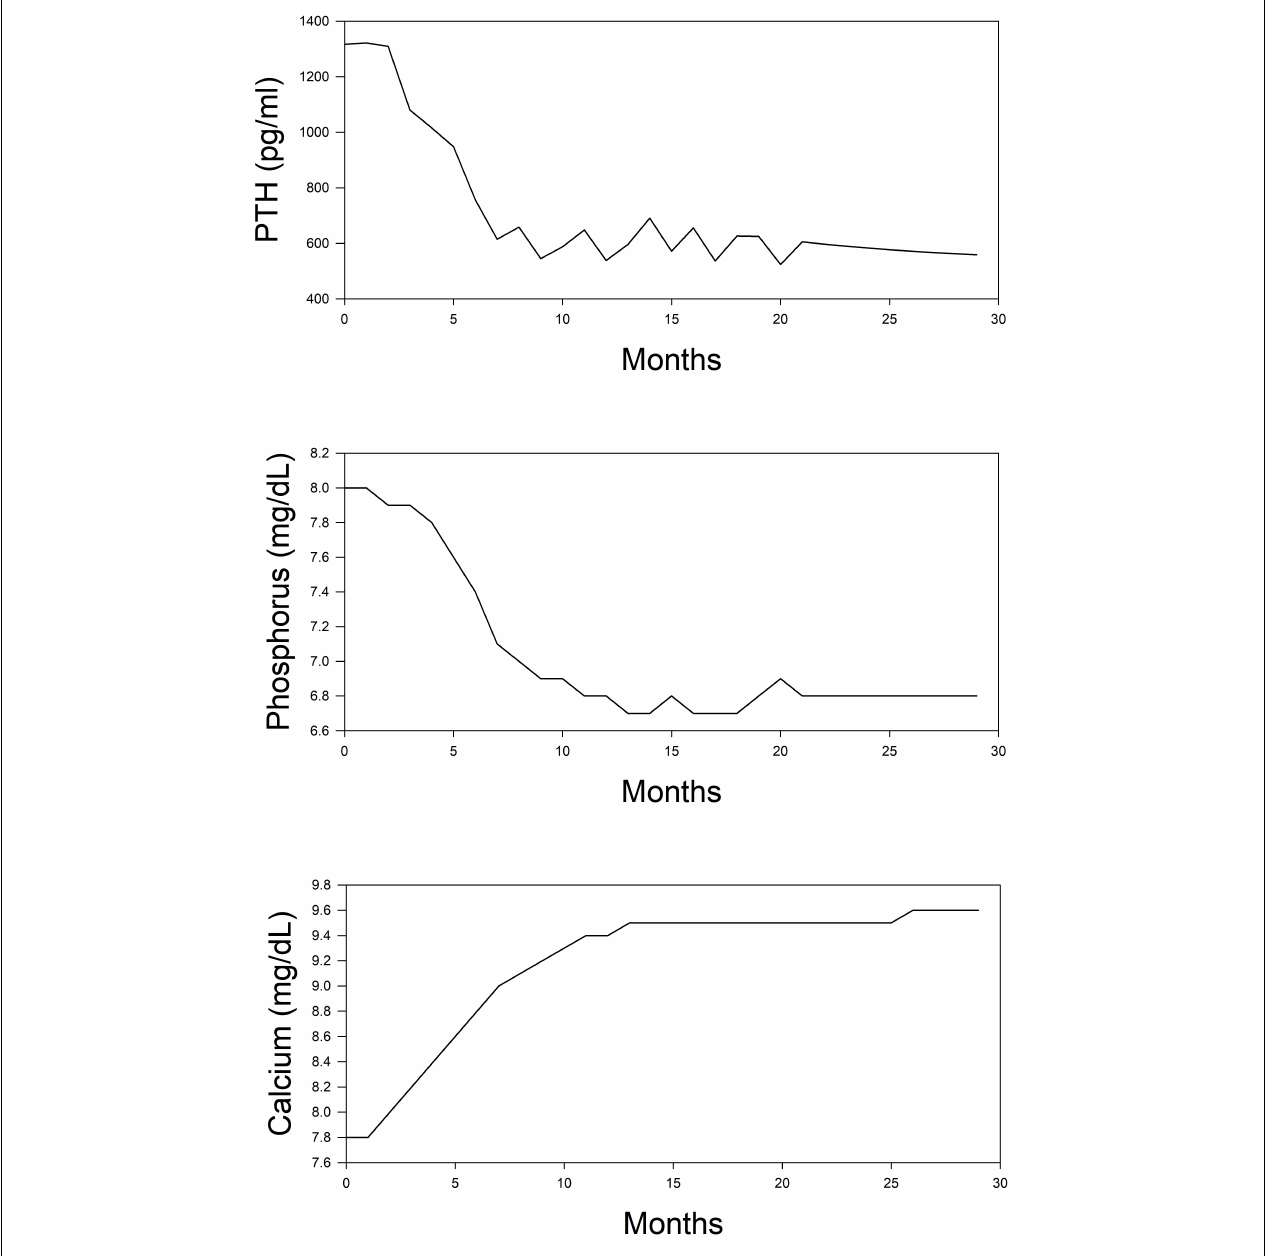
FIGURE 2 | Simplified depiction of the predicted time course of routinely measured markers of mineral metabolism in the simulated ( in silico ) treatment of CKD-MBD using phosphate binder, vitamin D analog, and a calcimimetic. Top panel, PTH; Middle panel, phosphorus; and Bottom panel, calcium.